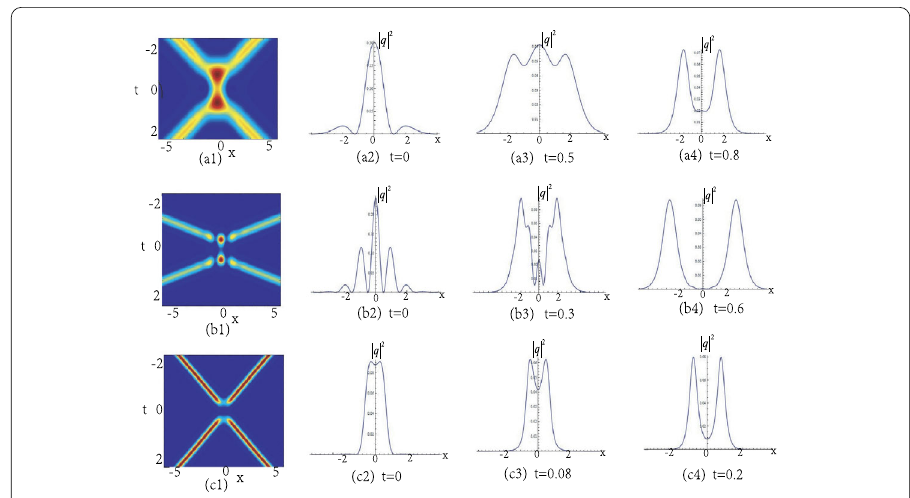
Figure 3 Interaction of the two-soliton solution for the nonlocal four-place DNLS equation (26). Pictures ( a1 )–( a4 ) show the interaction of the two-soliton for k 1 R = 1, k 1 I = 1. Pictures ( b1 )–( b4 ) show the interaction of the two-soliton for k 1 R = 3, k 1 I = 1. Pictures ( c1 )–( c4 ) show the interaction of the two-soliton for k 1 R = 1, k 1 I =